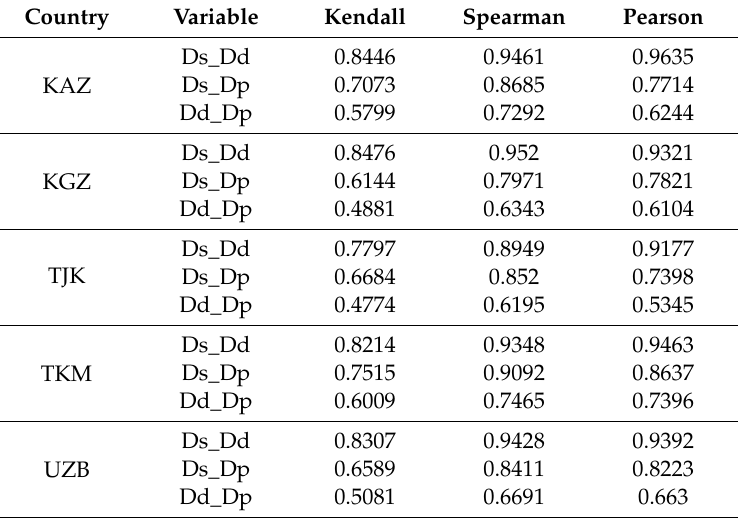
Table 3. Correlation coe ffi cients for drought events (SPEI < − 1, Dd > 2). Country Variable Kendall Spearman Pearson Ds_Dd KAZ